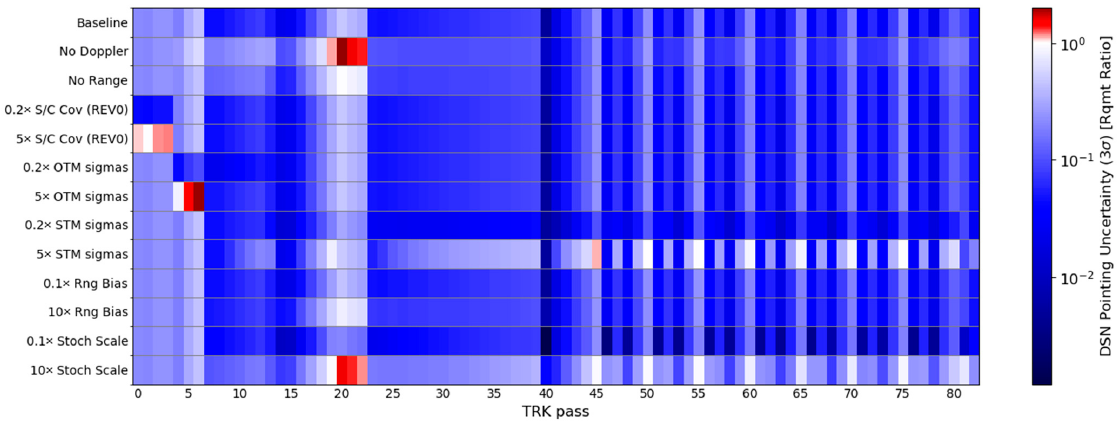
Figure 17. Full mission DSN pointing requirement ratio between the expected uncertainty and the requirement, for each tracking (TRK) pass, with respect to each relevant sensitivity case.